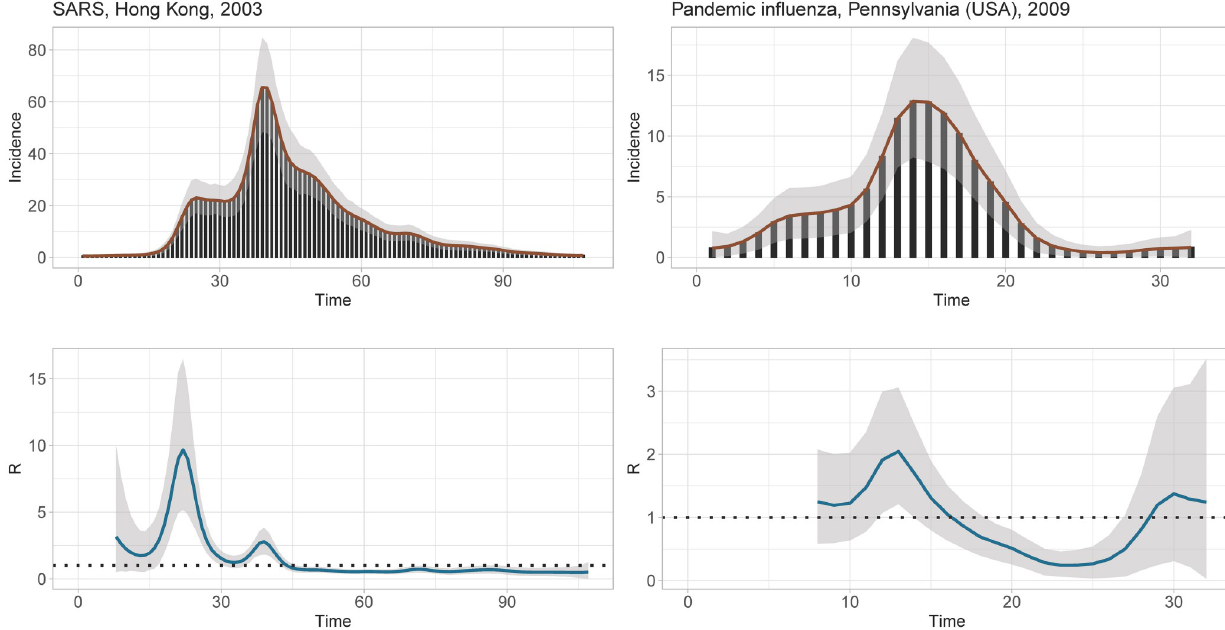
Fig 9. (Left column) EpiLPS fit for the epidemic curve (top) and the instantaneous reproduction number R Kong, 2003. (Right column) EpiLPS fit for the epidemic curve (top) and the instantaneous reproduction number R Pennsylvania, 2009. The shaded area corresponds to the 95% credible interval at each